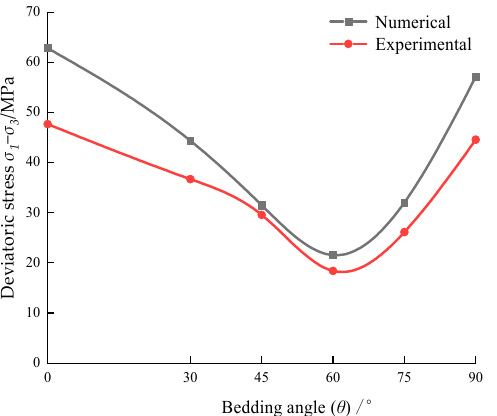
Figure 15. Comparison of numerical simulation and laboratory test results.